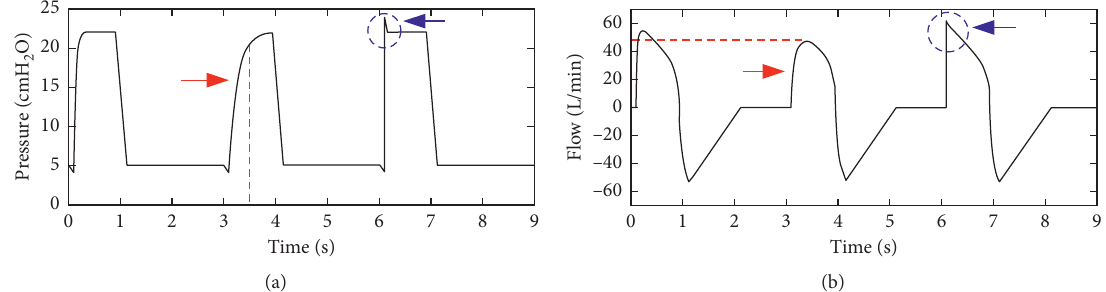
Figure 9: Ventilator waveforms of inspiration asynchrony.